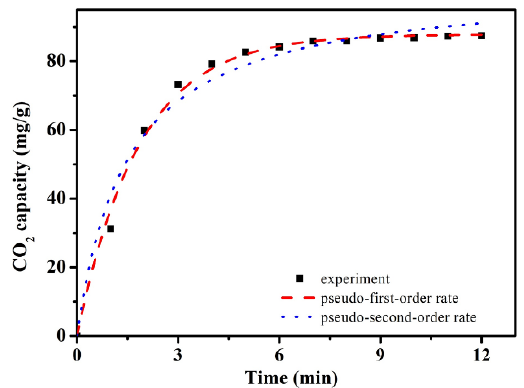
Table 2. Kinetics model parameters for CO 2 adsorption.